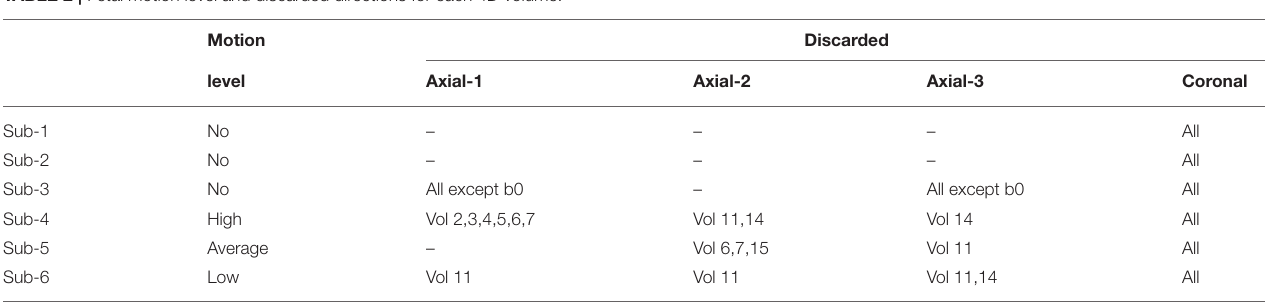
TABLE 2 | Fetal motion level and discarded directions for each 4D volume. Motion Discarded level Axial-1 Axial-2 Axial-3